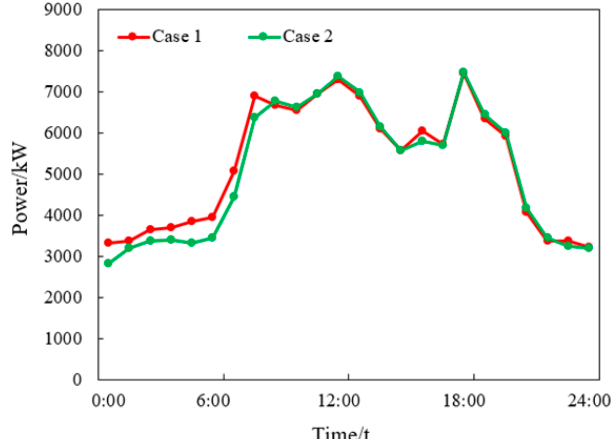
Figure 4. The output of turbine and gas boiler under two cases.